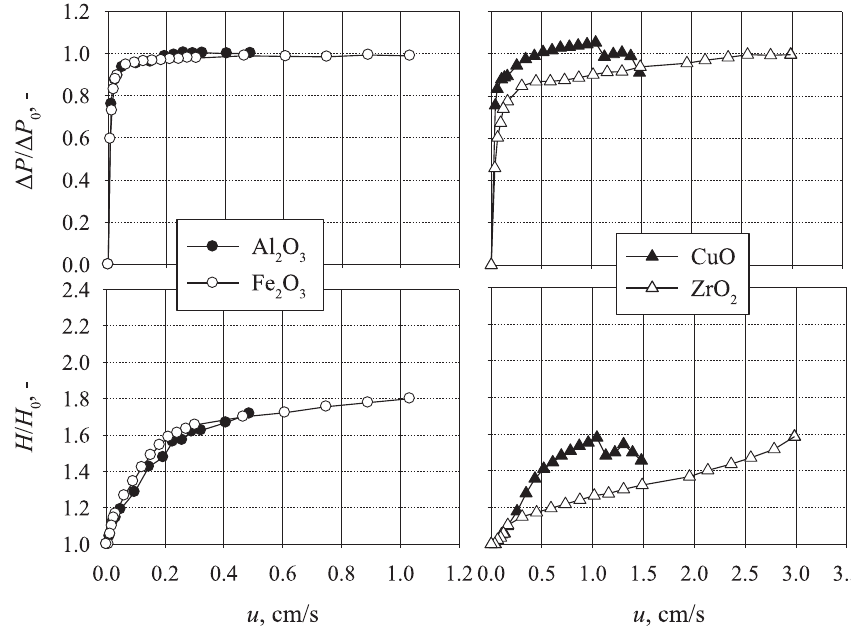
Fig. 2 Dimensionless pressure drop (Δ P /Δ P 0 ) and bed expansion ( H / H 0 ) obtained under sound-assisted condi - tions (140 dB–120 Hz).